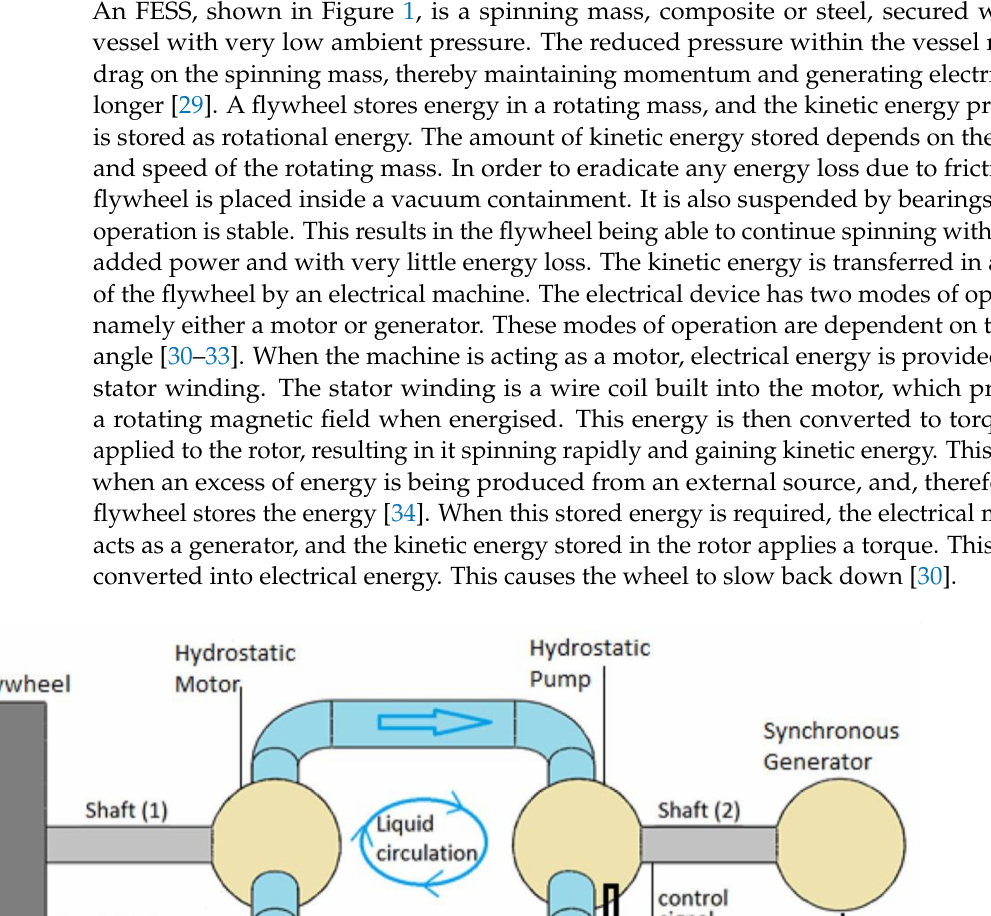
and offering very long lifetime (millions of full-depth discharge cycles) [41], ease of pro- duction [42,43], use, and decommissioning [44], especially with the current increase in renewable energy applications, as shown in Figure